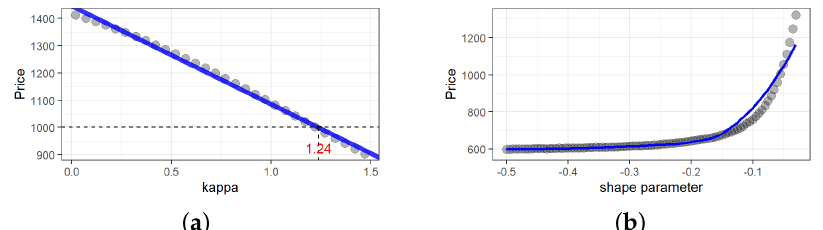
Figure 6. The empirical price at t = 0 varies with ( a ) the distortion parameter κ and ( b ) the shape parameter ξ with β / ξ = − 3342, κ = 1.24. Here, the empirical price is given by Equation (2) and a simulation of 10 5 samples of the threshold excess of maximum point precipitation from GP ξ , β , with all other parameters specified in Table